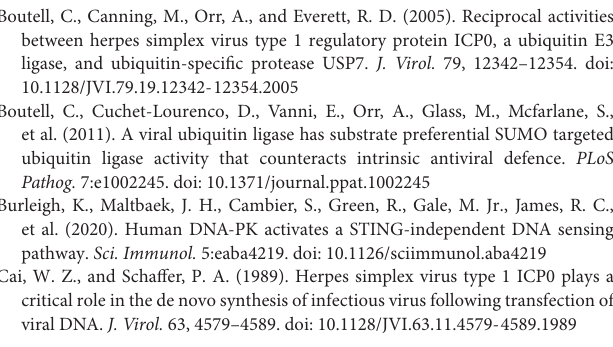
Supplementary Figure S1 | ICP0-interacting network. The functional clusters were generated by the K-mean approach based on the candidate ICP0-interacting proteins identified by the interactome analysis in all three cell lines. Supplementary Figure S2 | Validation of overexpression and knockdown of ICP0-interacting proteins in Neuro-2a cells. (A) Neuro-2a cells were transfected with the indicated plasmids (400 ng/ml) for 48 h before being harvested for Western blot analysis for the indicated proteins. (B) Neuro-2a cells were transfected with the indicated siRNA (120 nM) for 48 h before being harvested for Western blot analysis. NC, negative control. Supplementary Figure S3 | Potentially ubiquitinated viral proteins as detected by mass spectrometry. Red color indicates proteins potentially targeted by